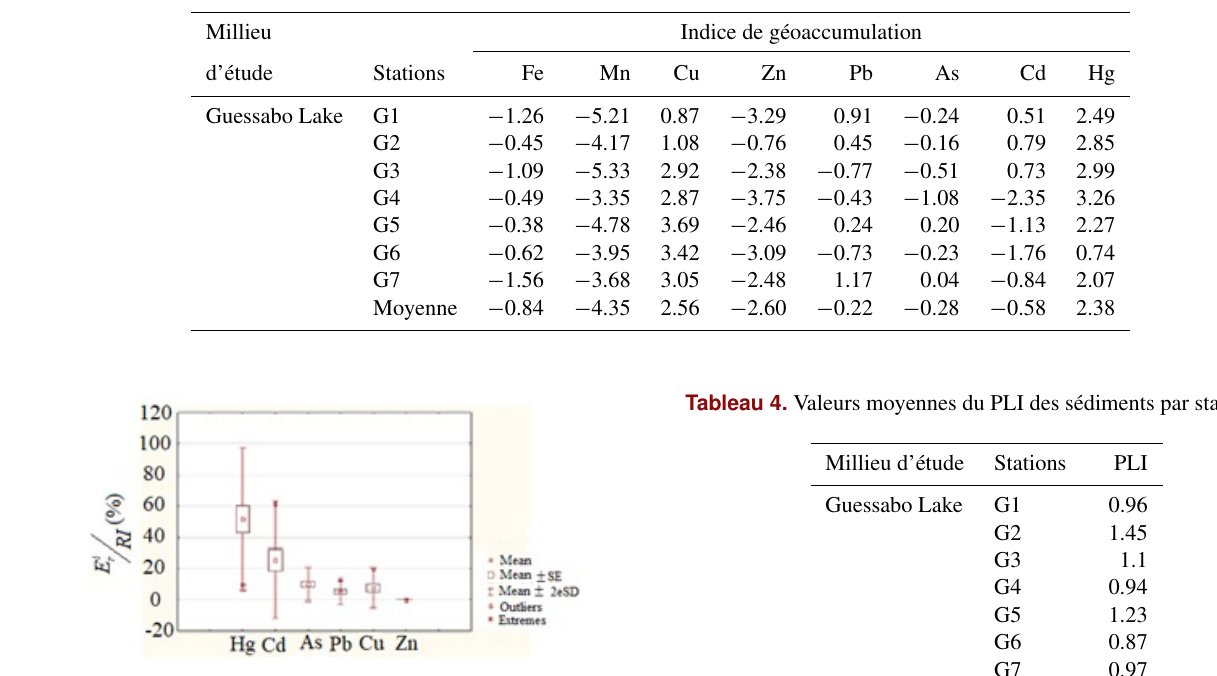
Figure 3. Contribution des métaux respective au RI.